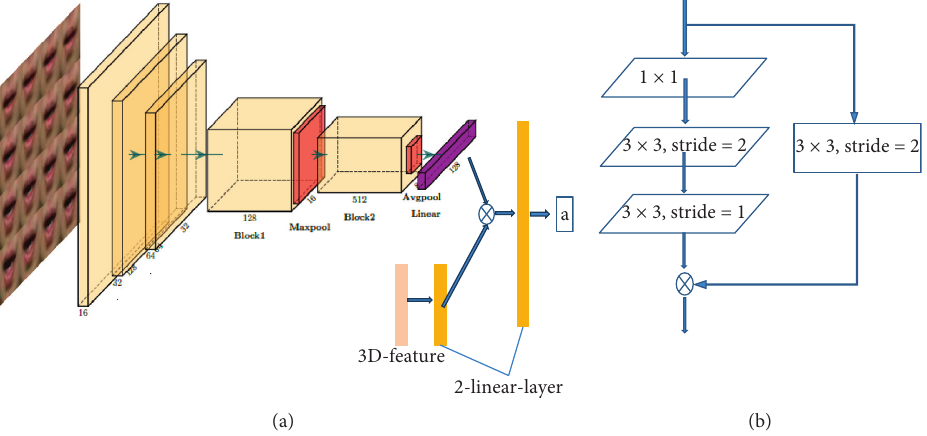
Figure 3: Our SCNet structure. (a) The overall structure of the model and (b) the skip connection structure.